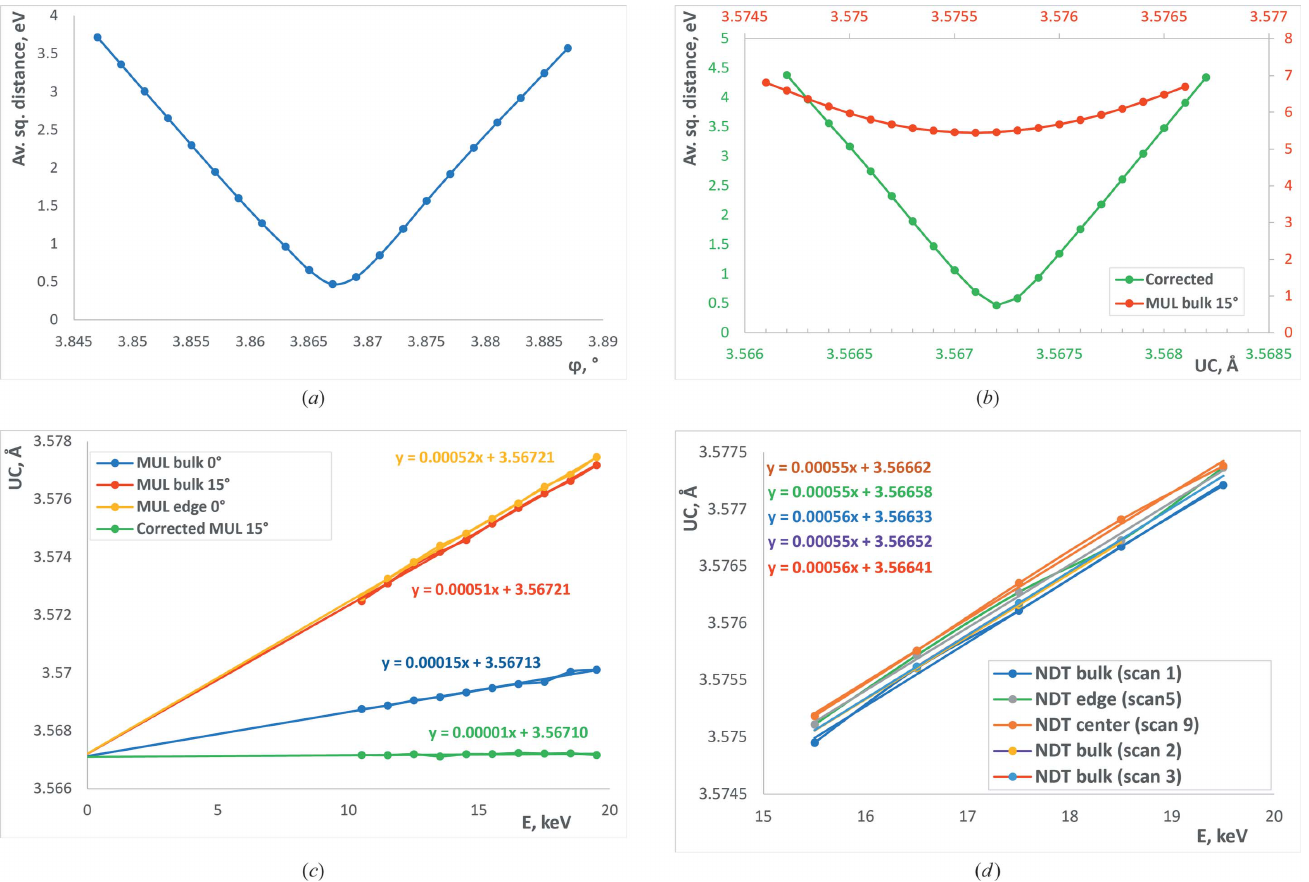
Figure 5 Sensitivity of glitches to ( a ) angle ’ and ( b ) UC parameter (red, before the energy correction; green, after). The apparent dependence of UC parameters on energy for ( c ) MUL lens (blue line is the scan before the monochromator re-tune, red and yellow lines after the re-tune, and the green line is the same data as the red line but after the energy correction) and for ( d ) NDT lens (different